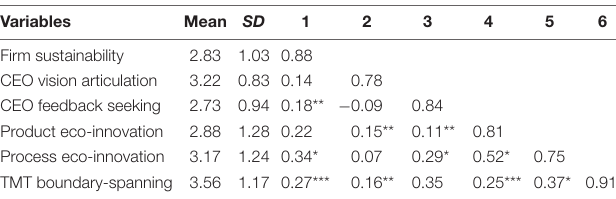
TABLE 1 | Descriptive statistics and correlations.